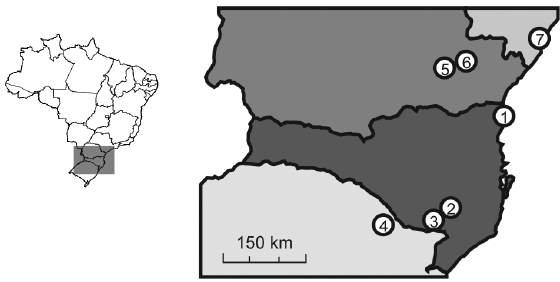
Fig. 3 – Southern Brazil with all cited